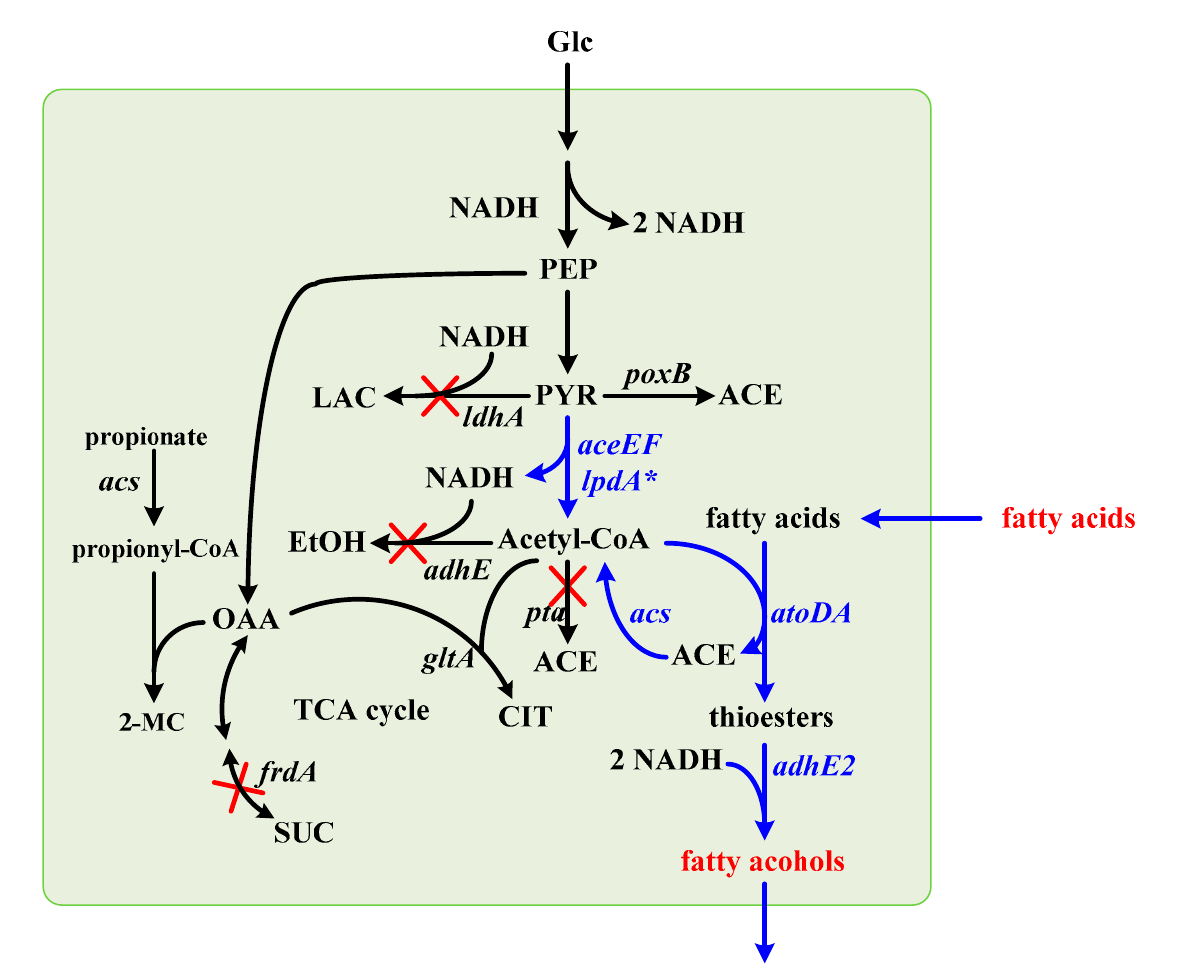
Figure 1. The biocatalytic pathway leading to fatty alcohols in E. coli . The biocatalytic pathway leading to fatty alcohols from short-chain fatty acids was introduced into E. coli by metabolic engineering. Undesired pathways were blocked by deletion of responsible genes as marked by “X”. The genes involved in the metabolic pathway: aceEF - lpdA *: pyruvate dehydrogenase complex; acs , acetyl-CoA synthetase; adhE , aldehyde-alcohol dehydrogenase; adhE2 , butyraldehyde-butanol dehydrogenase; atoDA , acetoacetyl-CoA transferase; ldhA , lactate dehydrogenase; frdA , subunit of fumarate reductase; gltA , citrate synthase; poxB , pyruvate oxidase; pta , phosphate acetyltransferase. Abbreviations: ACE, acetate; CIT, citrate; EtOH, ethanol; Glc, glucose; LAC, lactate; OAA, oxaloacetate; PEP, phosphoenolpyruvate; PYR, pyruvate; SUC, succinate; 2-MC, 2-methylcitrate.